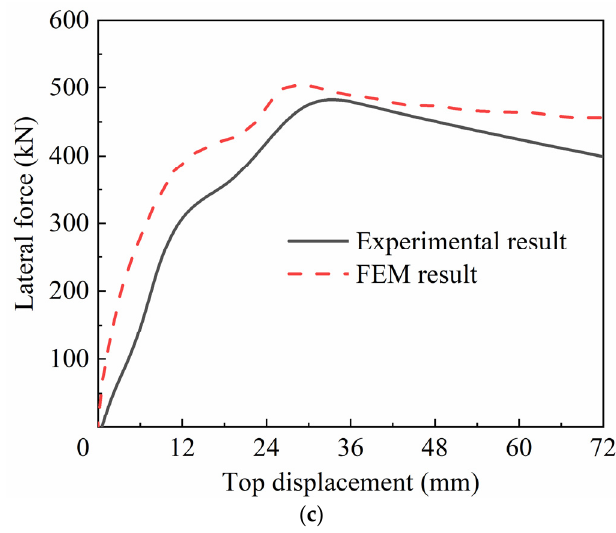
Figure 8. Comparison between the cracking modes and force–displacement curves of the experimental and FEM results: ( a ) cracking pattern of experimental results; ( b ) lateral displacement contour of numerical modeling results; ( c ) force–displacement curves.